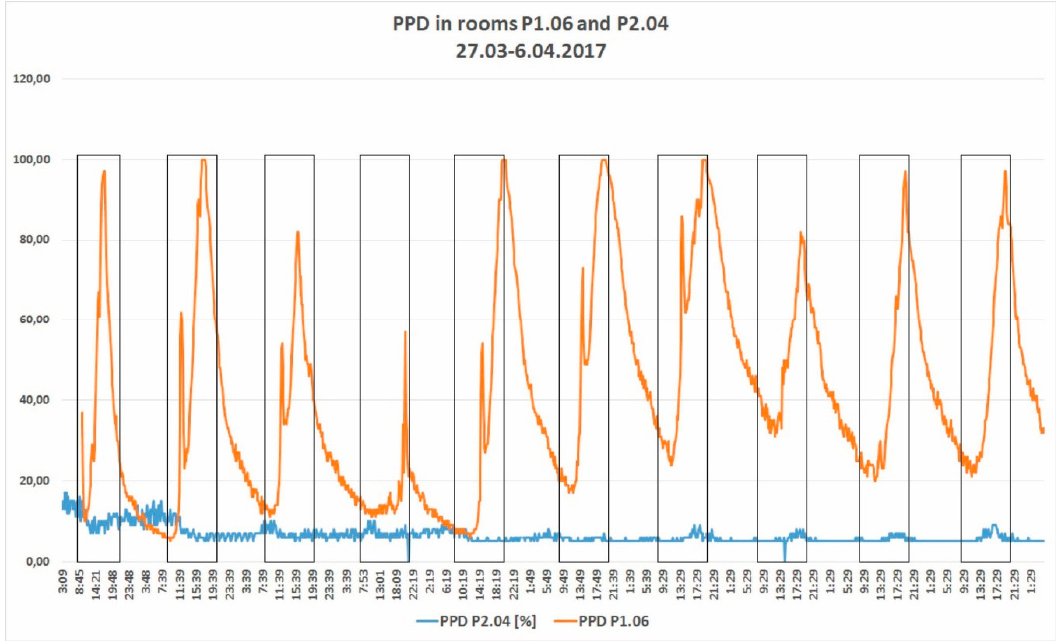
Figure 16. Values of predicted percentage of dissatisfied (PPD) index in rooms P1.06 and P2.04.